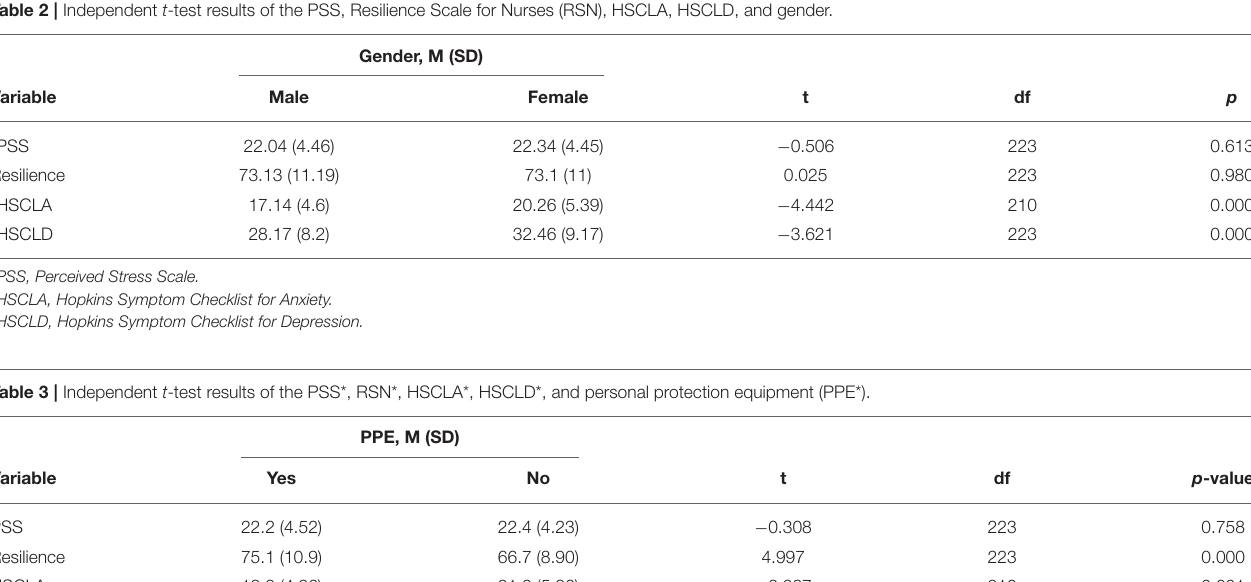
Table 2 | Independent t -test results of the PSS, Resilience Scale for Nurses (RSN), HSCLA, HSCLD, and gender. Variable